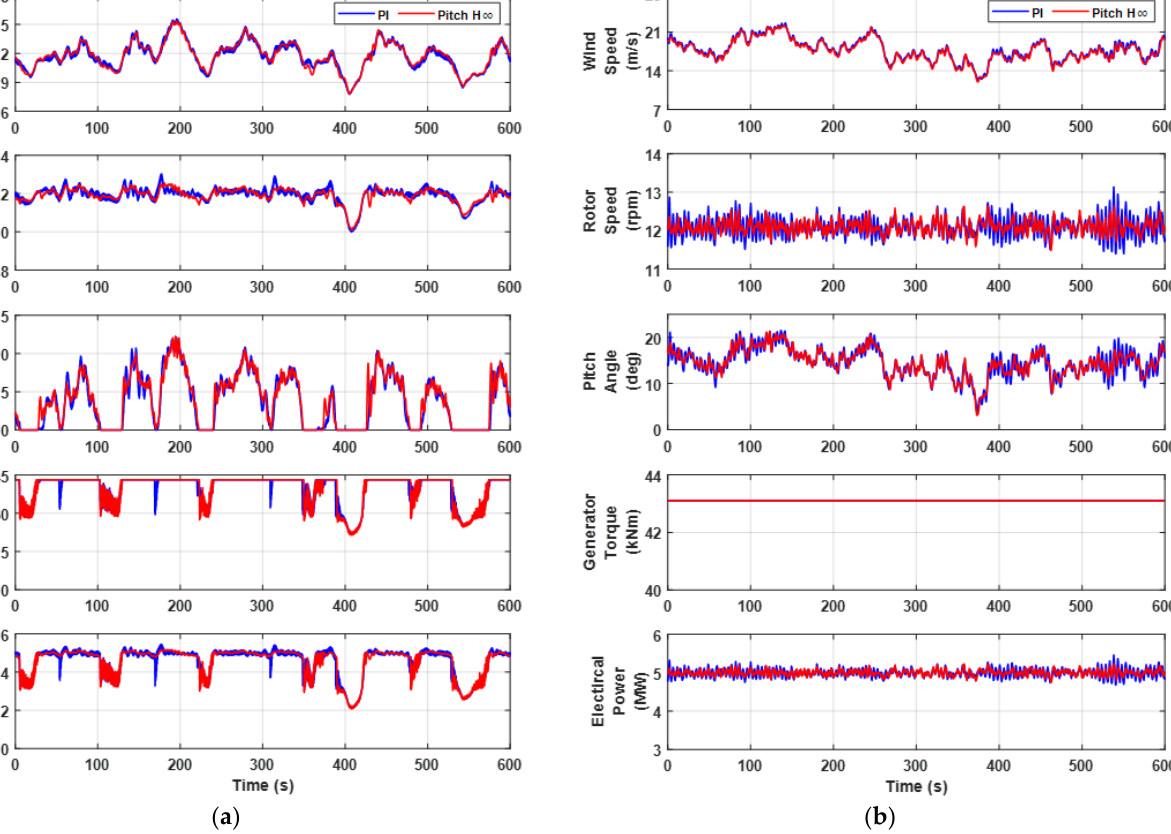
Figure 12. NTM results in noisy environments. ( a ) Wind speed of 12 m/s; ( b ) wind speed of 18 m/s. Table 4. Comparison of NTM results for performance data in 12 m/s noisy environment.